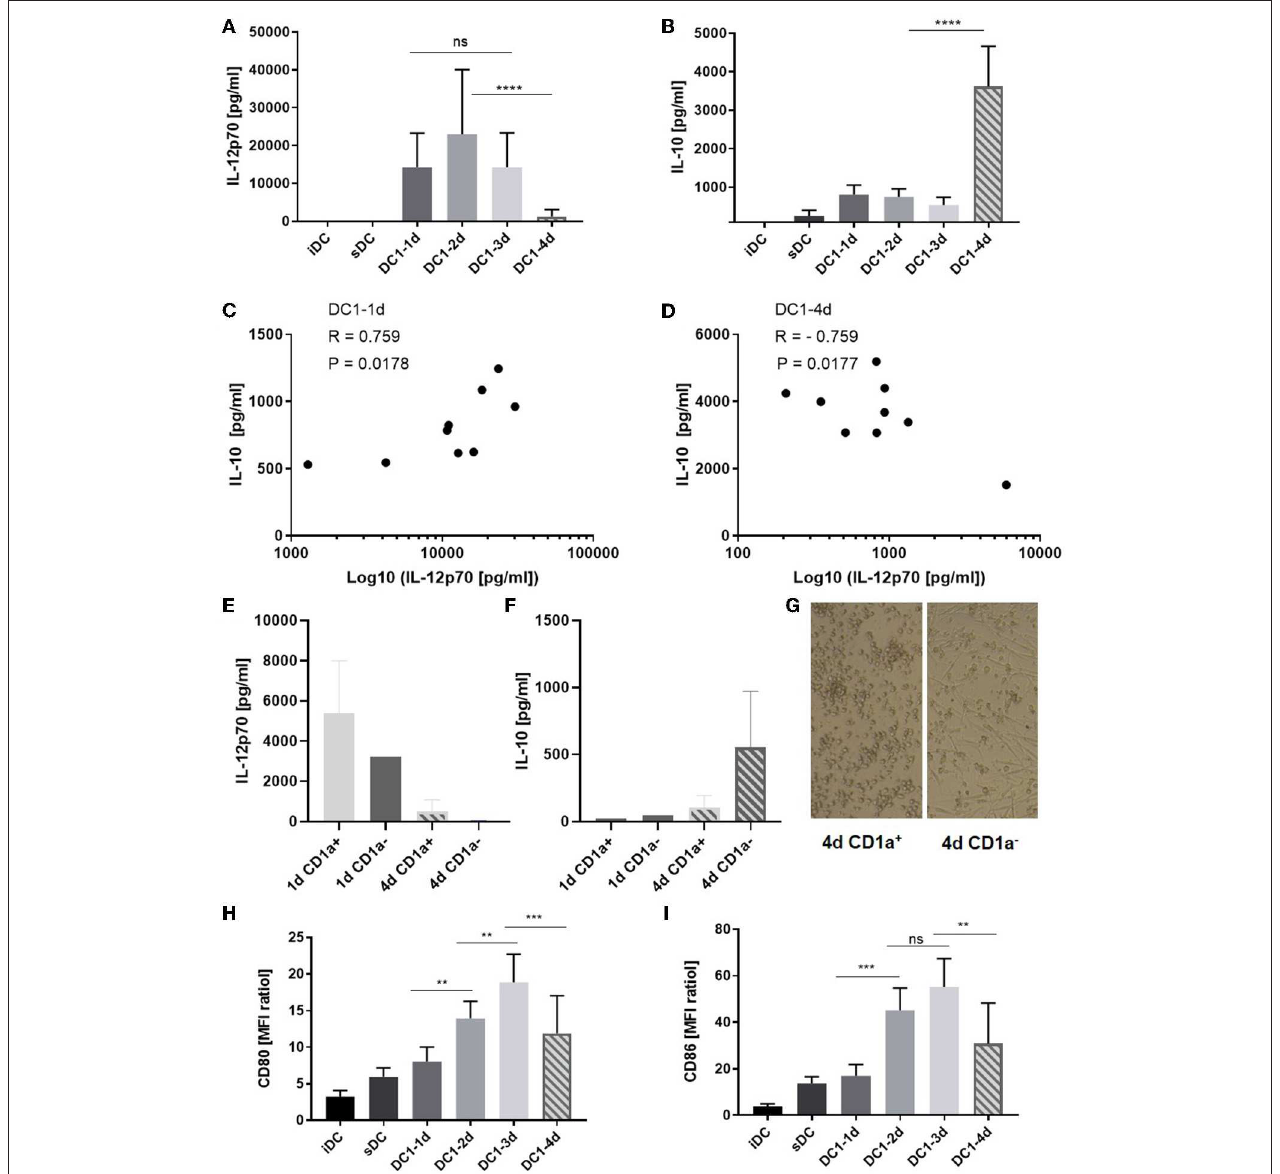
FIGURE 1 | Cytokine and co-stimulatory receptor alterations during extended maturation of DCs. Immature DCs activated with the DC1 (LPS + IFN γ ) cocktail were harvested after 1 (18h), 2, 3, or 4 days (DC1-1d, DC1-2d, DC1-3d, DC1-4d). Immature DCs (iDCs) and sDCs, stimulated with the gold standard activation cocktail (TNF α + IL-1 β + IL-6 + PGE 2 ) for 1 day (18h), were included for comparison. The concentrations of (A) IL-12p70 and (B) IL-10 were measured in the DC supernatants. Cumulative data are shown from five independent experiments with seven unique donors in total ( n = 9). Bars represent mean + standard